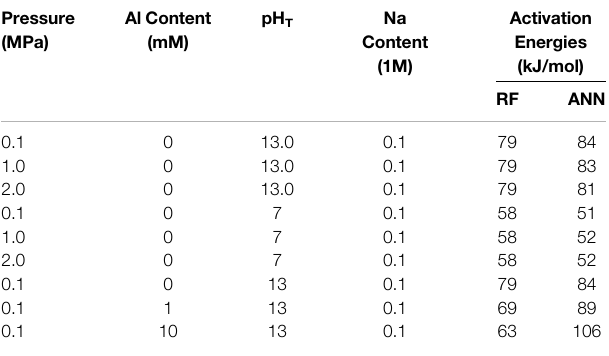
TABLE 4 | Comparison of the activation energies for quartz dissolution obtained by fi tting predicted quartz dissolution rates by the RF and ANN models with the Arrhenius equation ( Eq. 3